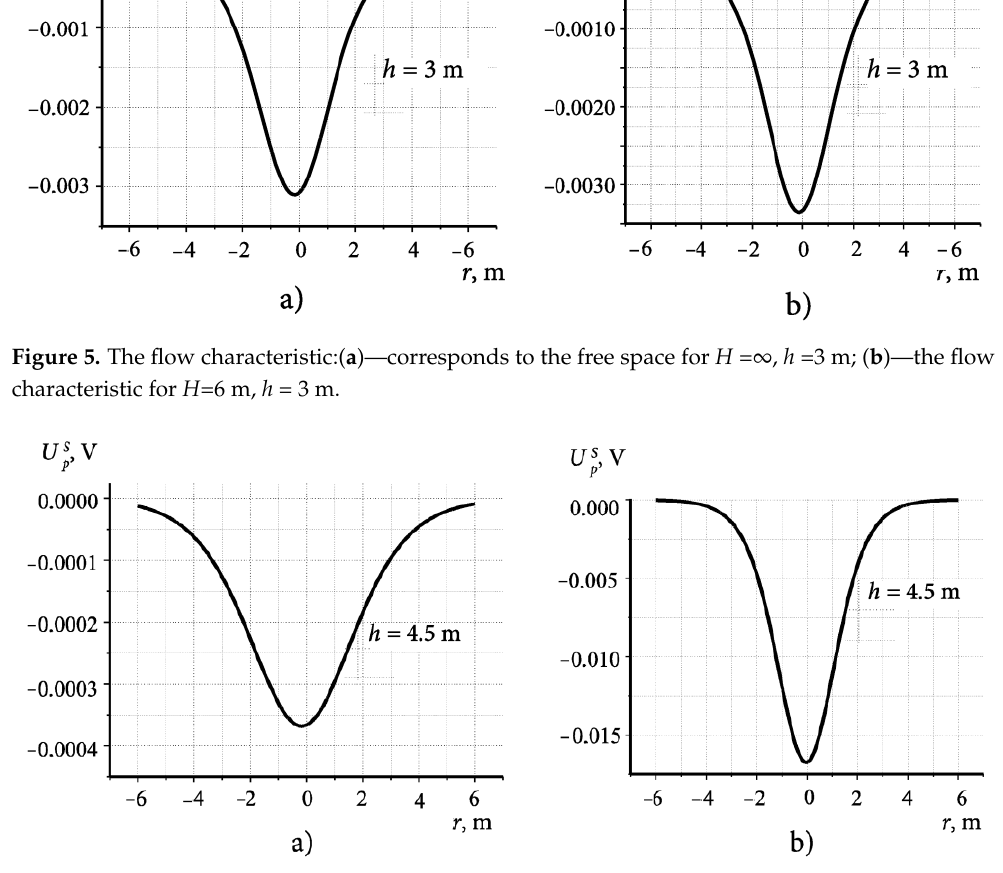
Figure 6. The flow characteristic: ( a ) — corresponds to the free spacefor H =∞, h =1.5 m; ( b ) — the flow characteristic H =6 m, for h = 4.5 m.